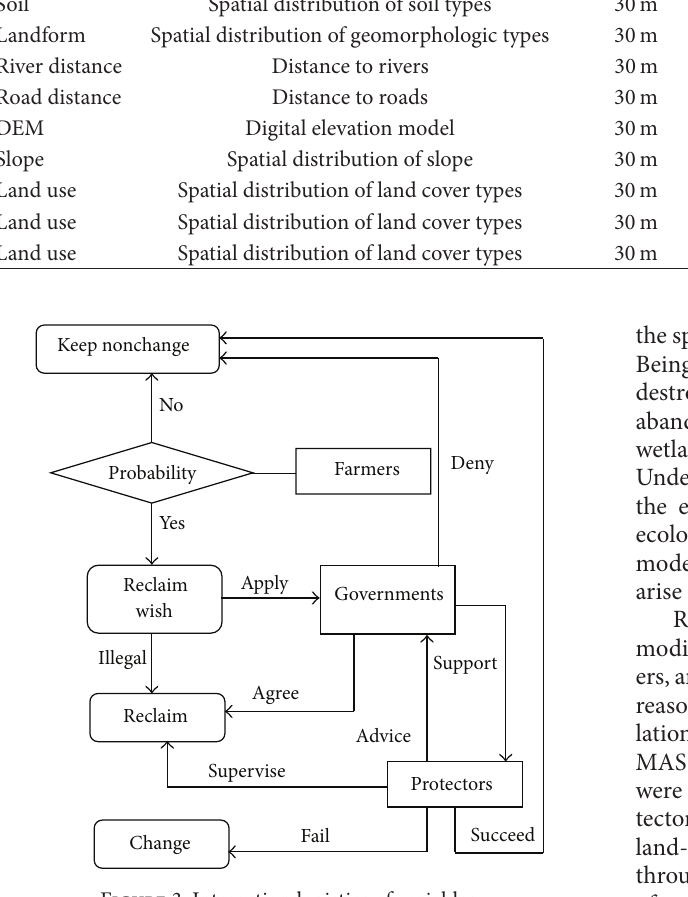
Figure 3: Interaction logistics of